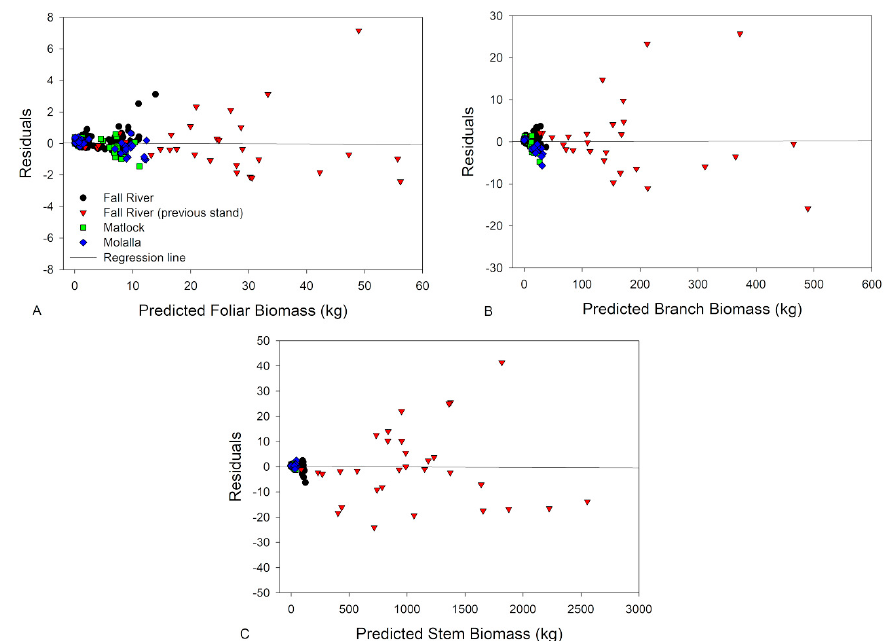
Figure 4. Biomass allocation model weighted residuals for foliar ( A ), branch ( B ), and stem ( C ) biomass.